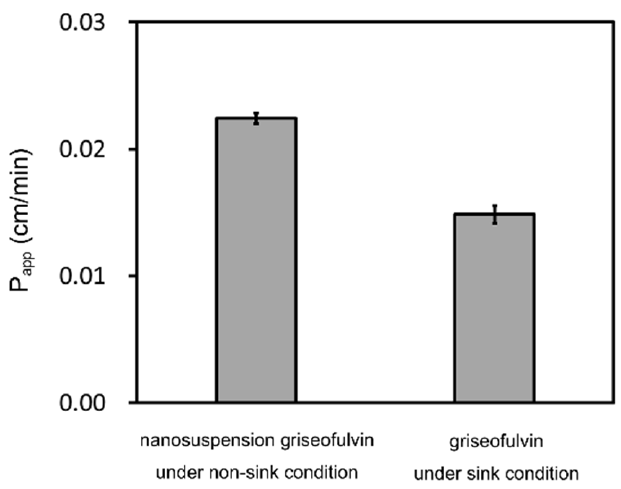
Figure 9. Comparison of P app of nanosuspension griseofulvin under non-sink conditions and sink conditions. The sink condition result is taken from our previous report [25]. The results represent the average P app ± SD ( n = 3). Adapted from [25], MDPI, 2021.